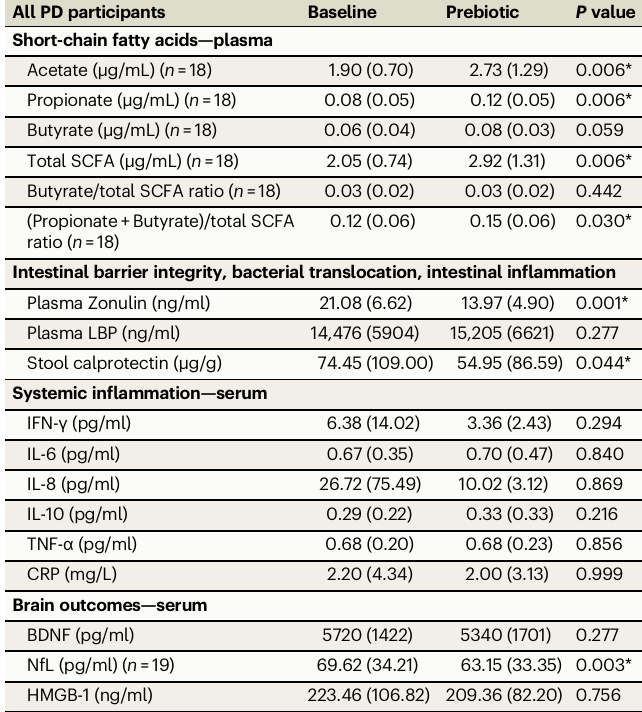
BDNF brain-derivedneurotrophicfactor, CRP C-reactive protein, HMGB-1 high-mobility group box 1 protein, IFN- γ interferon-gamma, IL interleukin, LBP lipopolysaccharide-binding protein, NfL neuro fi lament light chain, TNF- α tumornecrosis factor-alpha. *Signi fi cance: P value <0.05. n =20PD participants,unlessnoted above. All data areshown as mean (standarddeviation). BasedontheShapiro-Wilks normalitytest,eitheratwo-tailed,parametricpaired t testoratwo- tailed, non-parametricWilcoxonsigned-rank testwas usedfor analysis.